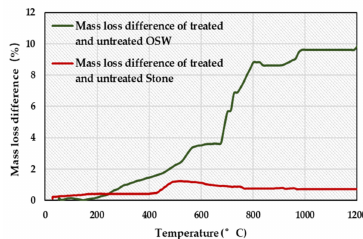
Figure 13. Mass loss di ff erence of treated and untreated OSW and stone at di ff erent